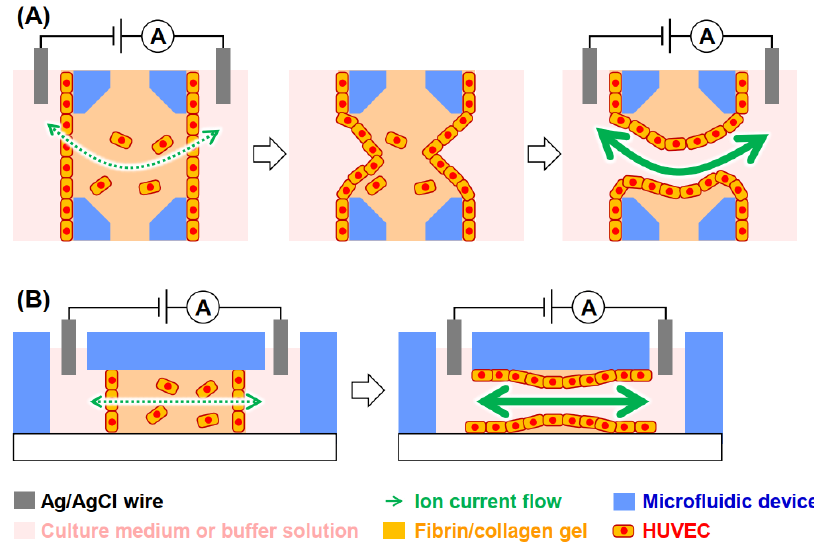
Figure 1. Strategy of ion conductance-based perfusability assay of vessel formation in microfluidic devices. ( A ) Top and ( B ) side views. Although the illustration is simplified, a potentiostat was used to measure ion currents.